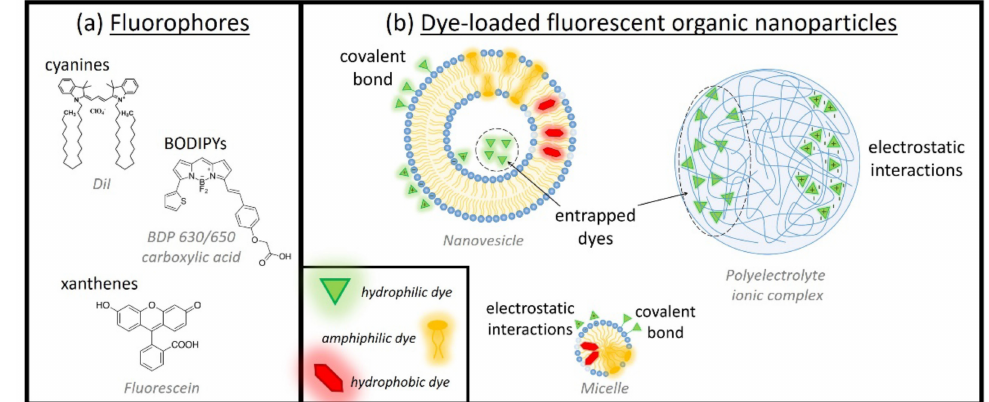
Figure 4. ( a ) Chemical structure of several fluorophores commonly used for FON preparation. ( b ) Schematic representation of different strategies to stably integrate fluorescent molecules into organic